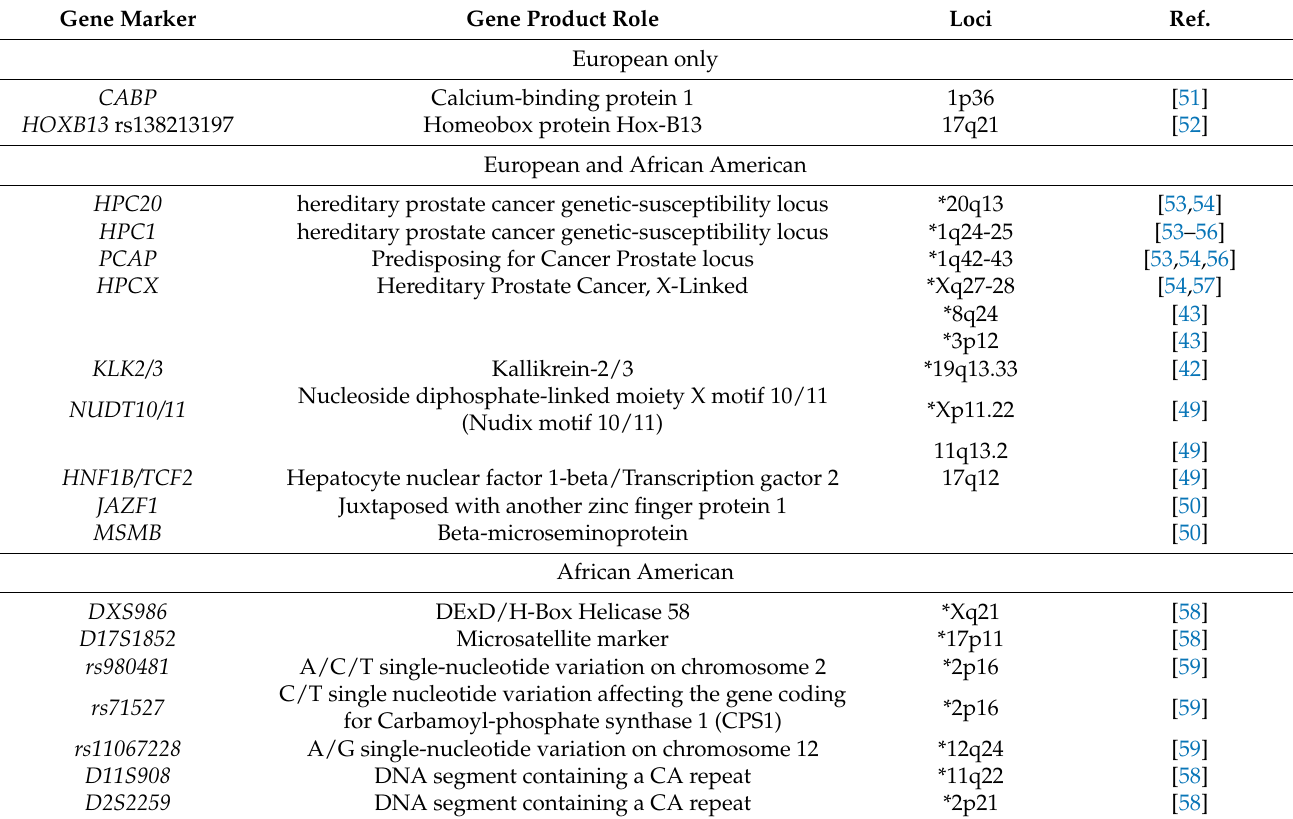
Table 1. Prostate cancer population risk associated